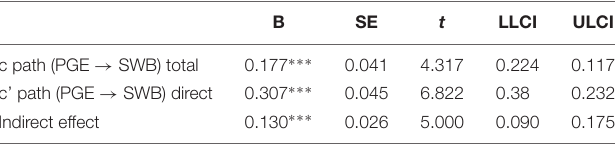
TABLE 6B | Mediation analysis of commitment between PGE and Well-being (total sample). B SE ULCI c path (PGE → SWB)